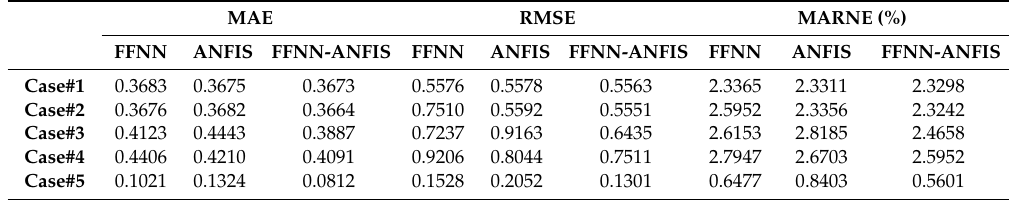
Table 1. Comparison of the forecasting models considering the minute-ahead horizon. MAE RMSE